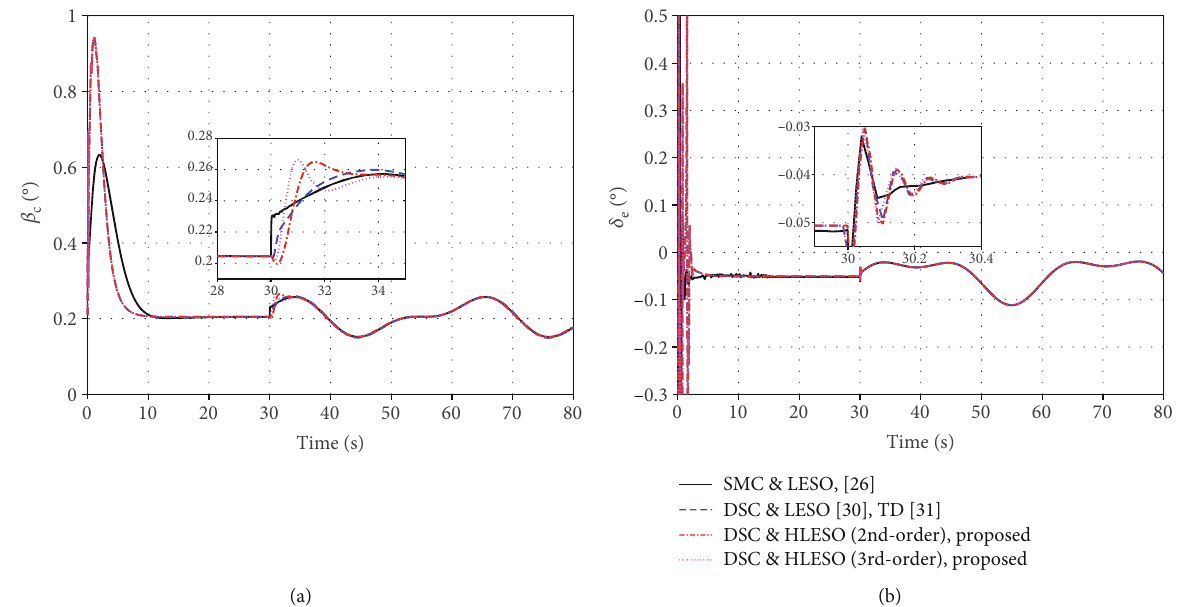
Figure 6: Actuator response curves: (a) throttle setting and (b) elevator de fl